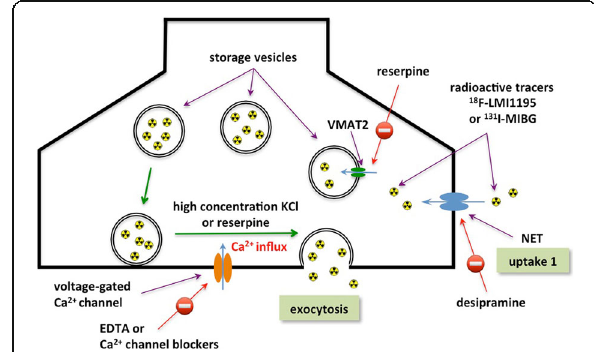
Fig. 6 Illustration of radiotracer uptake, storage, and release mechanisms in PC12 cells. In PC12 cells, radiotracers ( 18 F-LMI1195 or 131 I-MIBG) that have been selectively taken up into the cells are first stored in storage vesicles and can be released by either high concentrations of KCl or reserpine. This procedure is Ca 2+